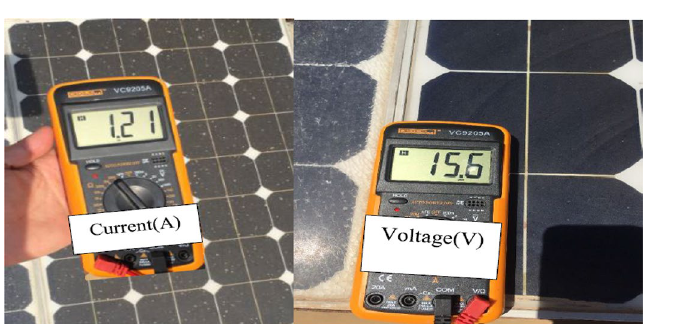
Figure 15. Experimental current and voltage of the proposed PV system.